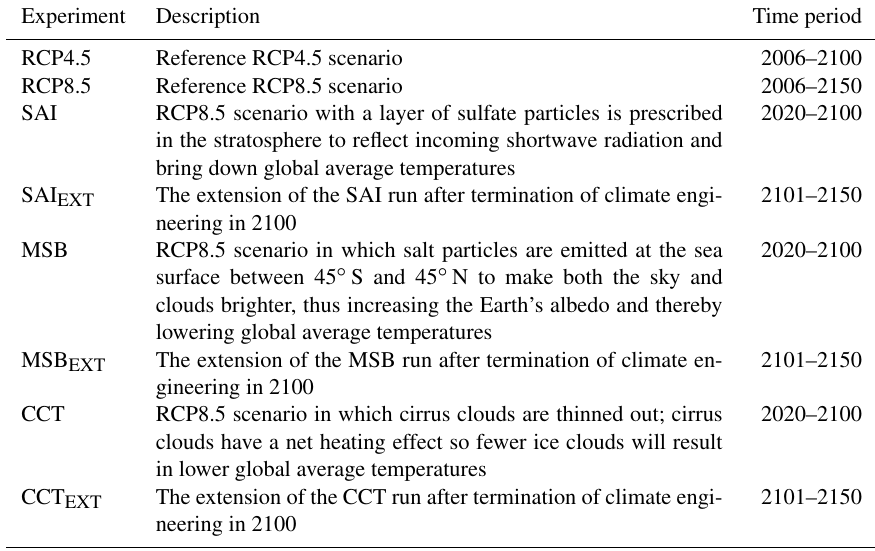
Table 2. General description of the model experiments used in this